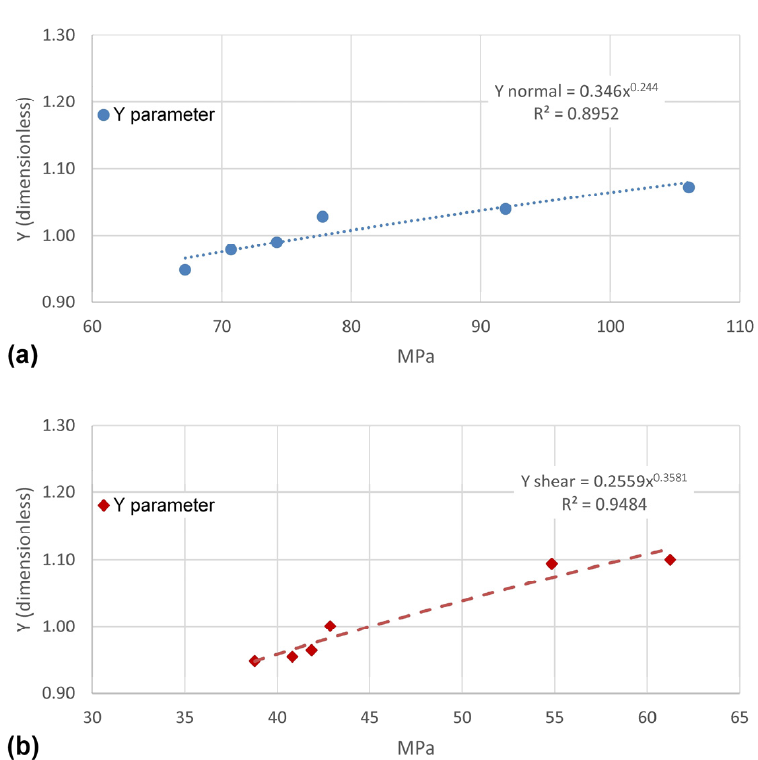
Figure 5. Variation of the Y parameter, magnesium alloy AZ31BF, ( a ) as a function of normal stress amplitude, ( b ) as a function of shear stress